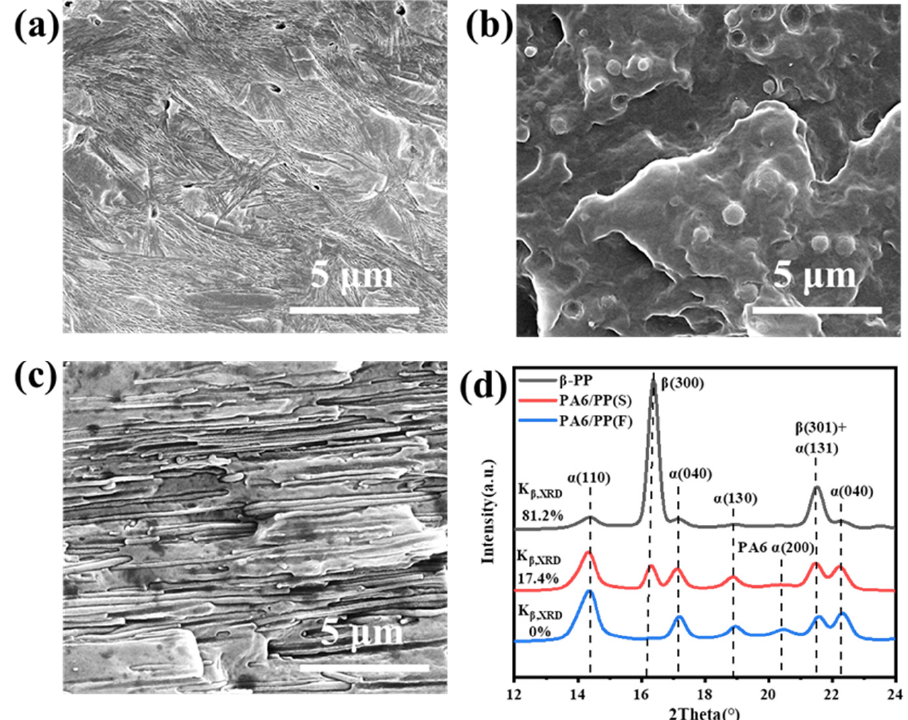
Figure 1. ( a ) Cross-sectional SEM images of β -PP unstretched films, with the amorphous area etched out. The cryo-fractured surface SEM images of ( b ) PA6/PP(S) and ( c ) PA6/PP(F) unstretched films. ( d ) XRD curves of three unstretched films.